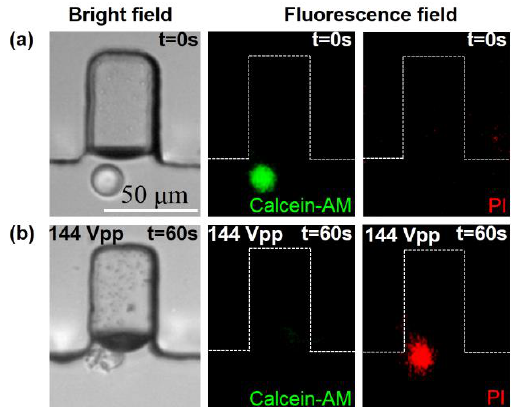
Figure 8. MCF-7 cell lysis. ( a ) The image series shows a single cell in the vicinity of the air bubble before the application of the ultrasound sonication. As the MCF-7 cell membrane is intact, the green fluorescence generated by the living cells is observed. ( b ) After the application of the ultrasound irradiation, the MCF-7 cell is broken into pieces, and only the red fluorescence of the PI is observed.